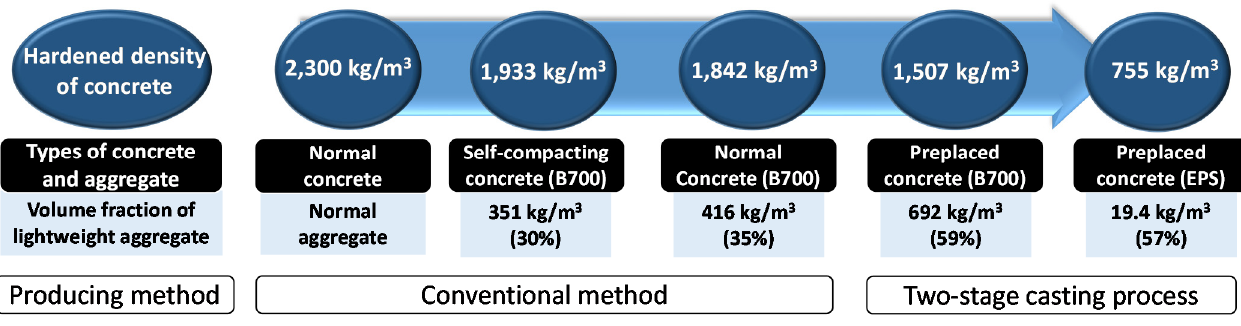
Figure 9. Flow chart of research for producing lightweight